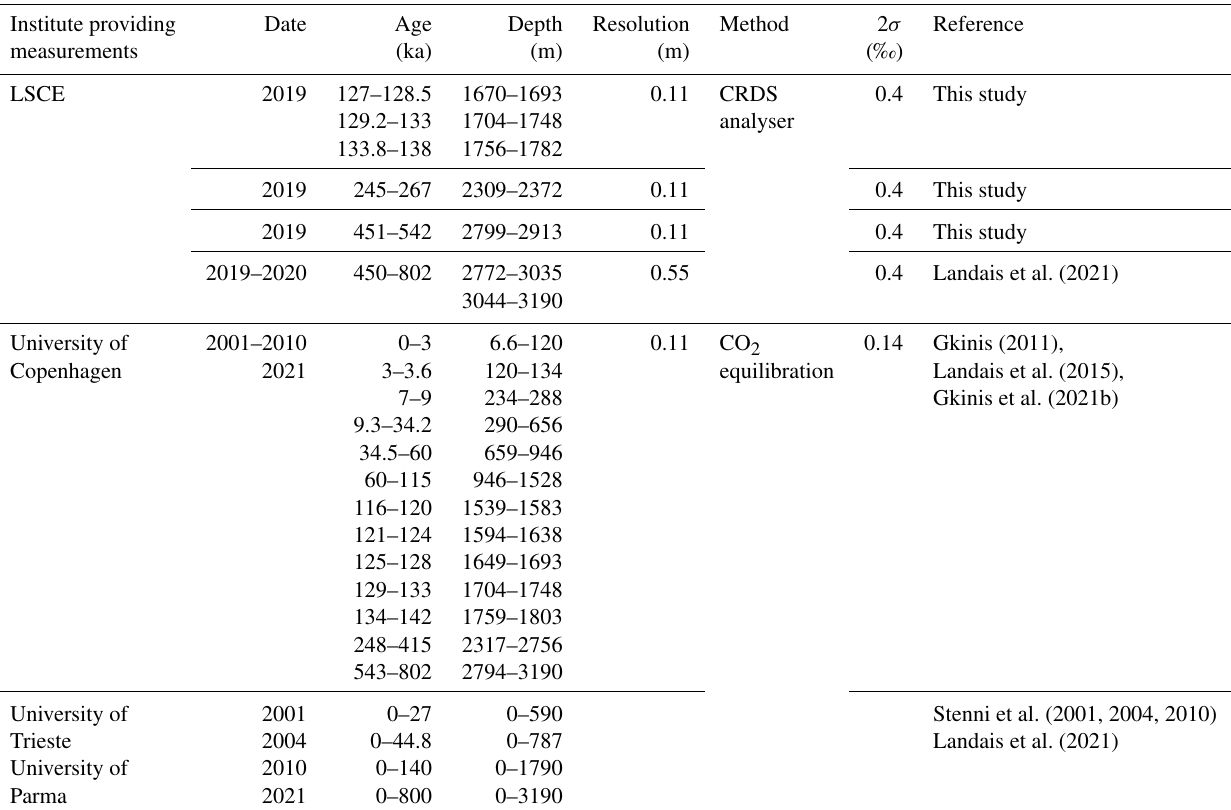
Table 2. Summary of available δ 18 O measurements of the EDC ice core and associated analytical methods. 2 σ values come from instrumental measurement uncertainty as provided in the original